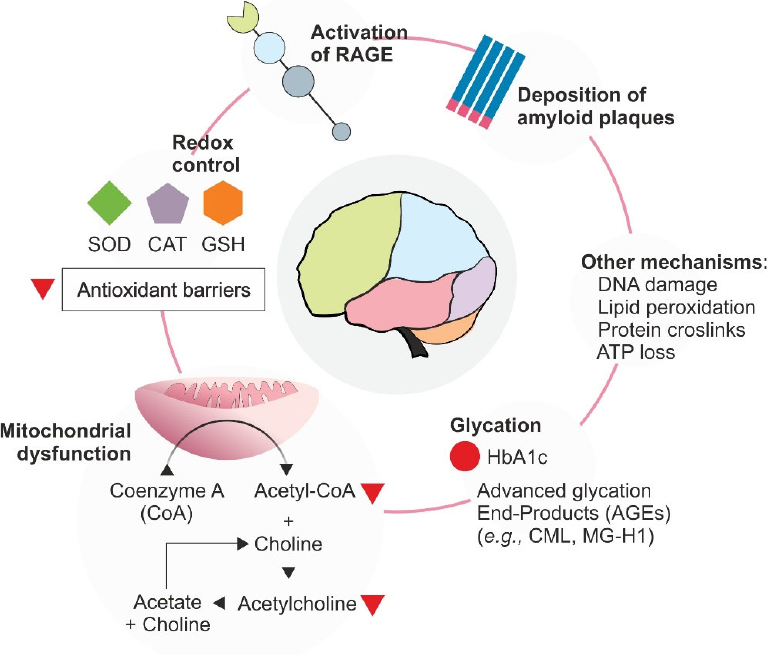
Figure 2. Schematic representation of some biological mechanisms in the interplay of glycation, neurodegeneration, and the progression of oxidative stress. Mechanisms in brain degeneration are highlighted. Both glycation and cellular degeneration are involved in the activation of local ( i.e., brain) and systemic oxidative stress. The accumulation of dysfunctional mitochondria, DNA damage, lipid peroxidation, and/or energetic imbalance induces severe damage to cells. AGEs, as well as A β‐ peptides, have related stress activation on membrane ‐ RAGE, which is a promiscuous receptor interacting with both ligands. CML: carboxymethyl ‐ lysine; MG ‐ H1: N δ‐ (5 ‐ hydro ‐ 5 ‐ methyl ‐ 4 ‐ imidazolon ‐ 2 ‐ yl)ornithine.